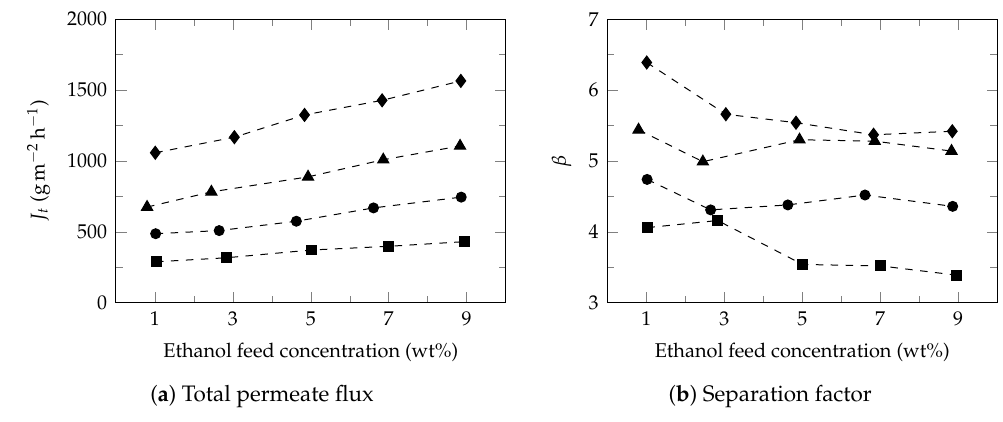
Figure 2. Total flux and separation factor. Feed temperature: 34°C ( (cid:4) ), 40°C (